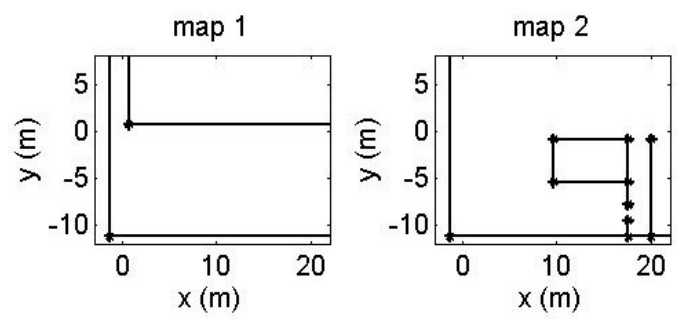
Figure 8. The incomplete map